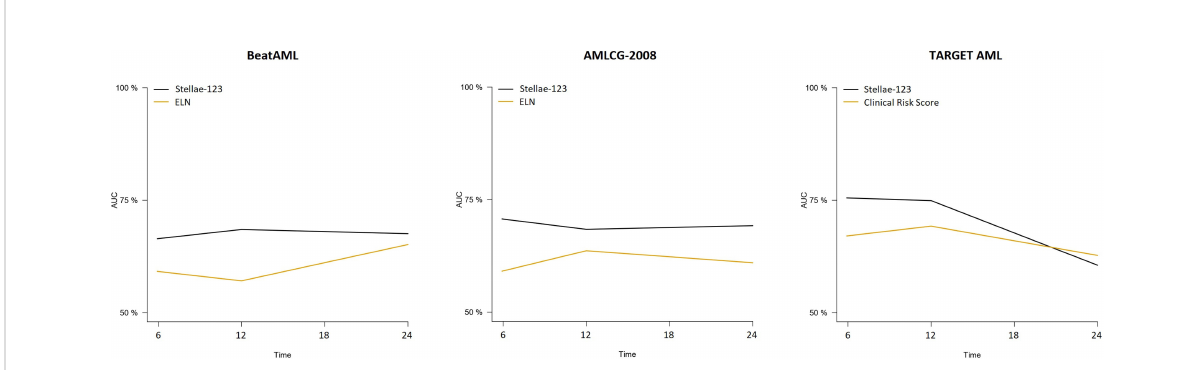
FIGURE 2 Time-dependent AUCs at 6, 12, 18 and 24 months for the Stellae-123 signature across all the cohorts. For comparison, the performance of the ELN-2017 in the BetaAML and AMLCG-2008 cohorts is shown. In the pediatric TARGET AML cohort, the performance of the pediatric clinical risk score was plotted.